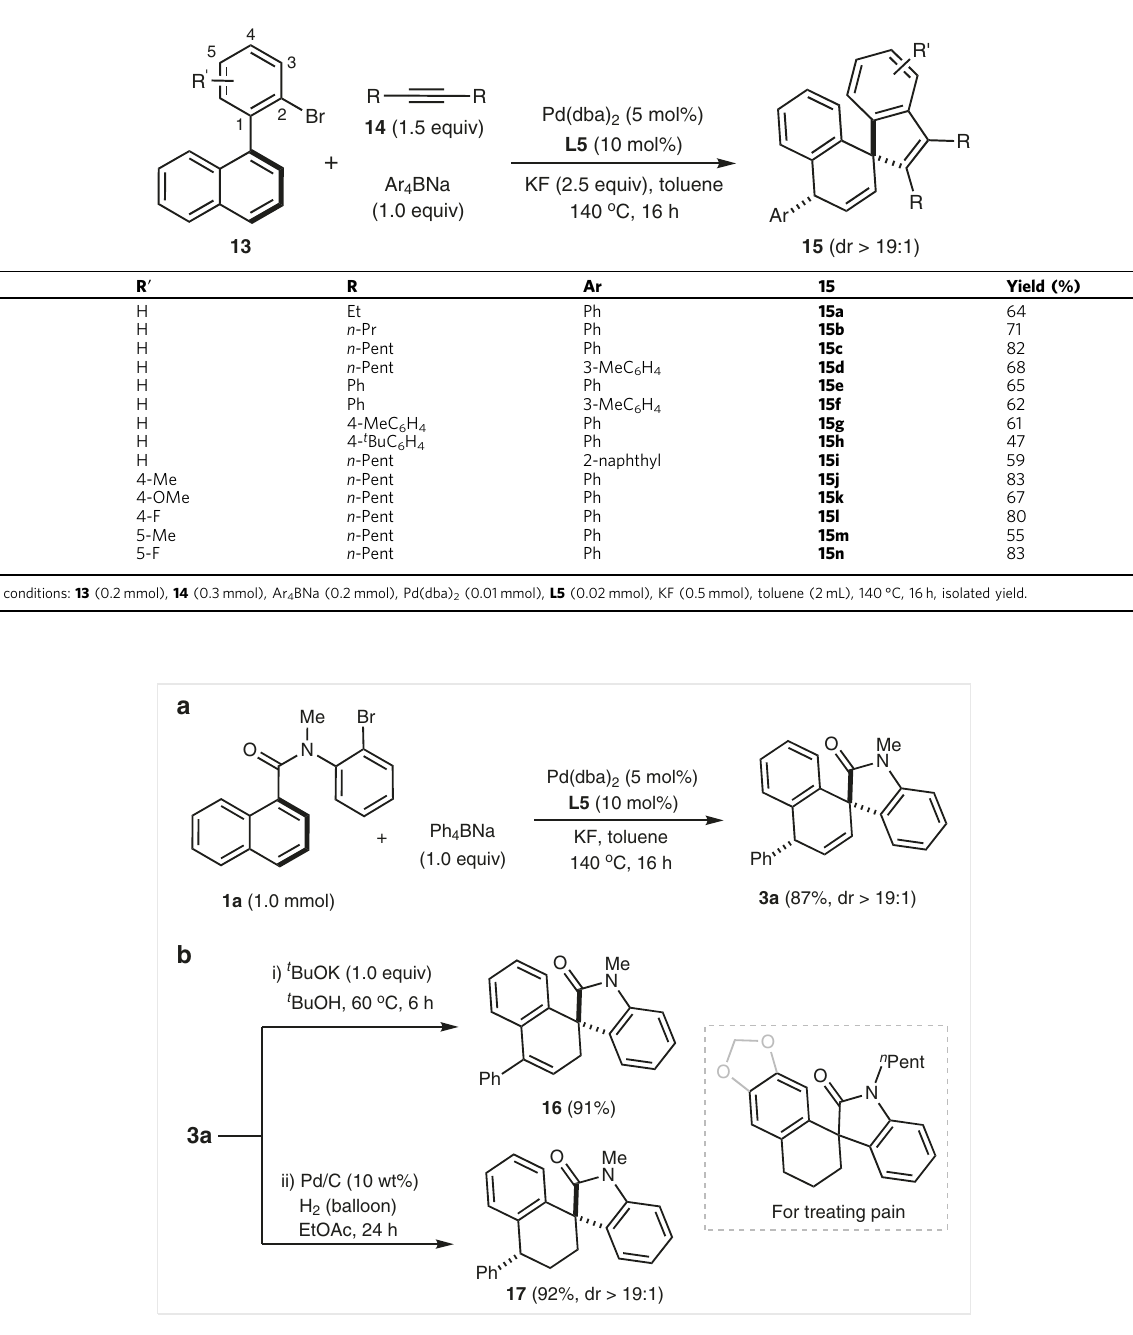
bond and the spiro-scaffold disfavors the intrinsic regioselectivity toward 1,2-difunctionalization, allowing the observed 1,4- difunctionalization. Methods General procedure for the reaction of 1, 8, or 11 . To a dried Schlenk tube were added 1 , 8 , or 11 (0.20 mmol), Pd(dba) 2 (5.8 mg, 0.010 mmol), ligand L5 (9.2 mg,